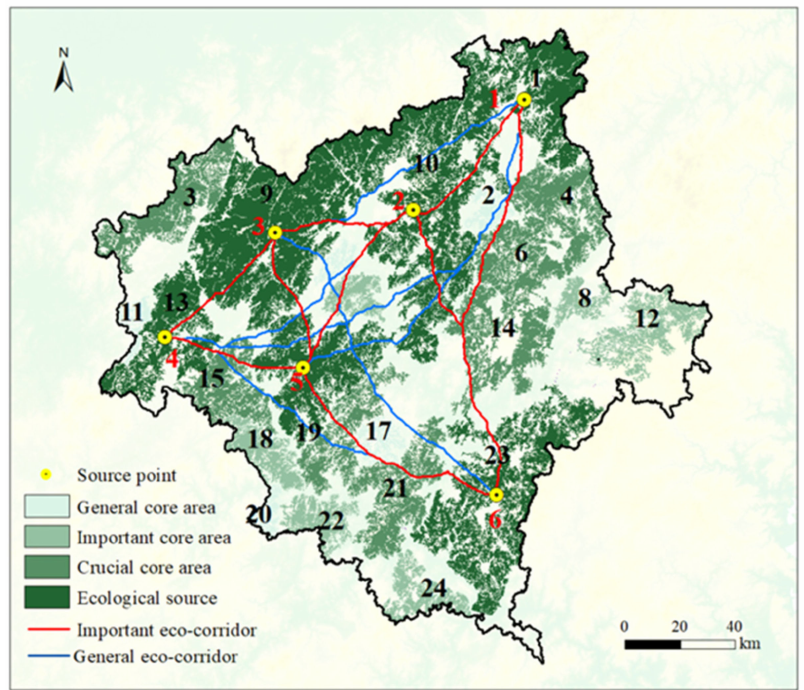
Figure 8. Distribution of the potential ecological network structure in the study